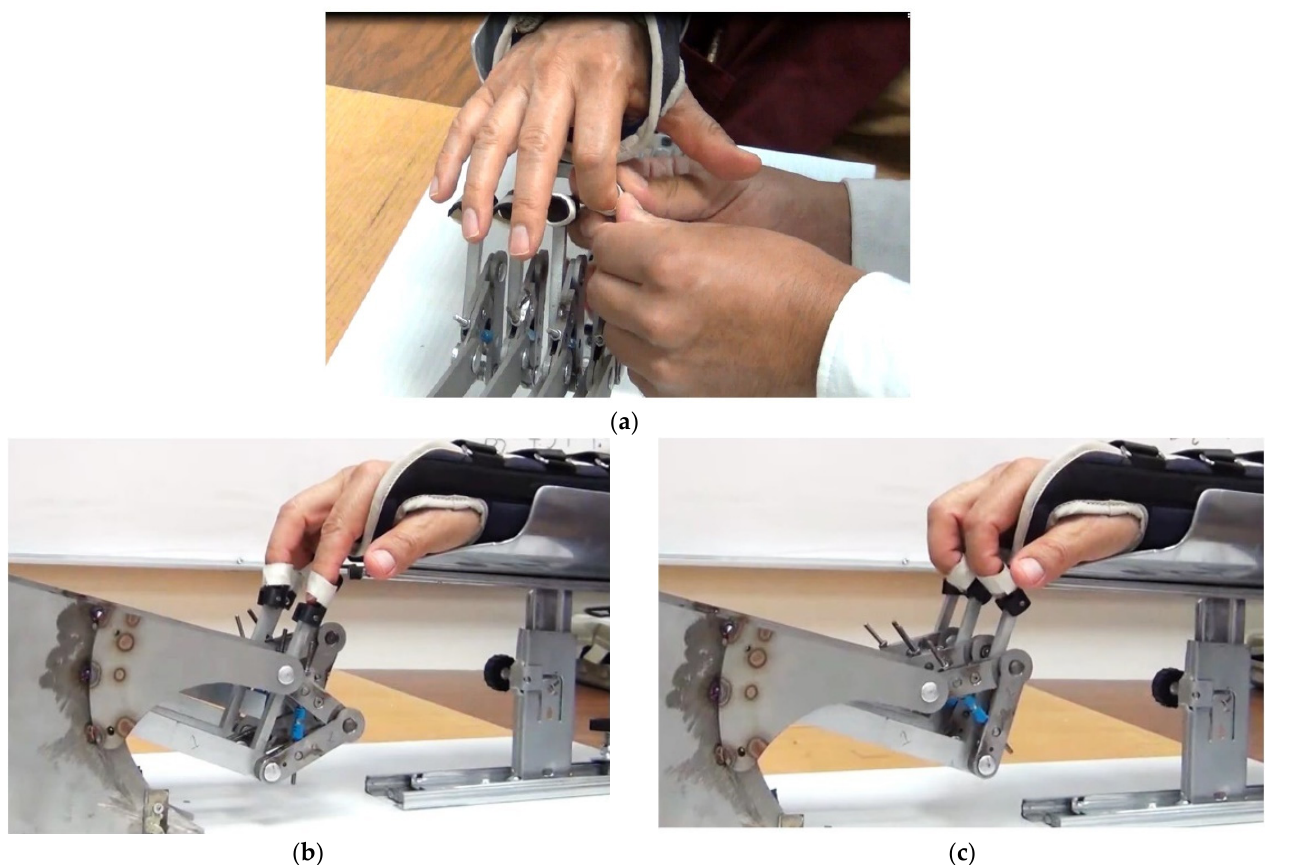
Figure 17. Snapshots of the A-AFiM motion during the test: ( a ) Starting position, ( b ) extension motion, and ( c ) flexion motion